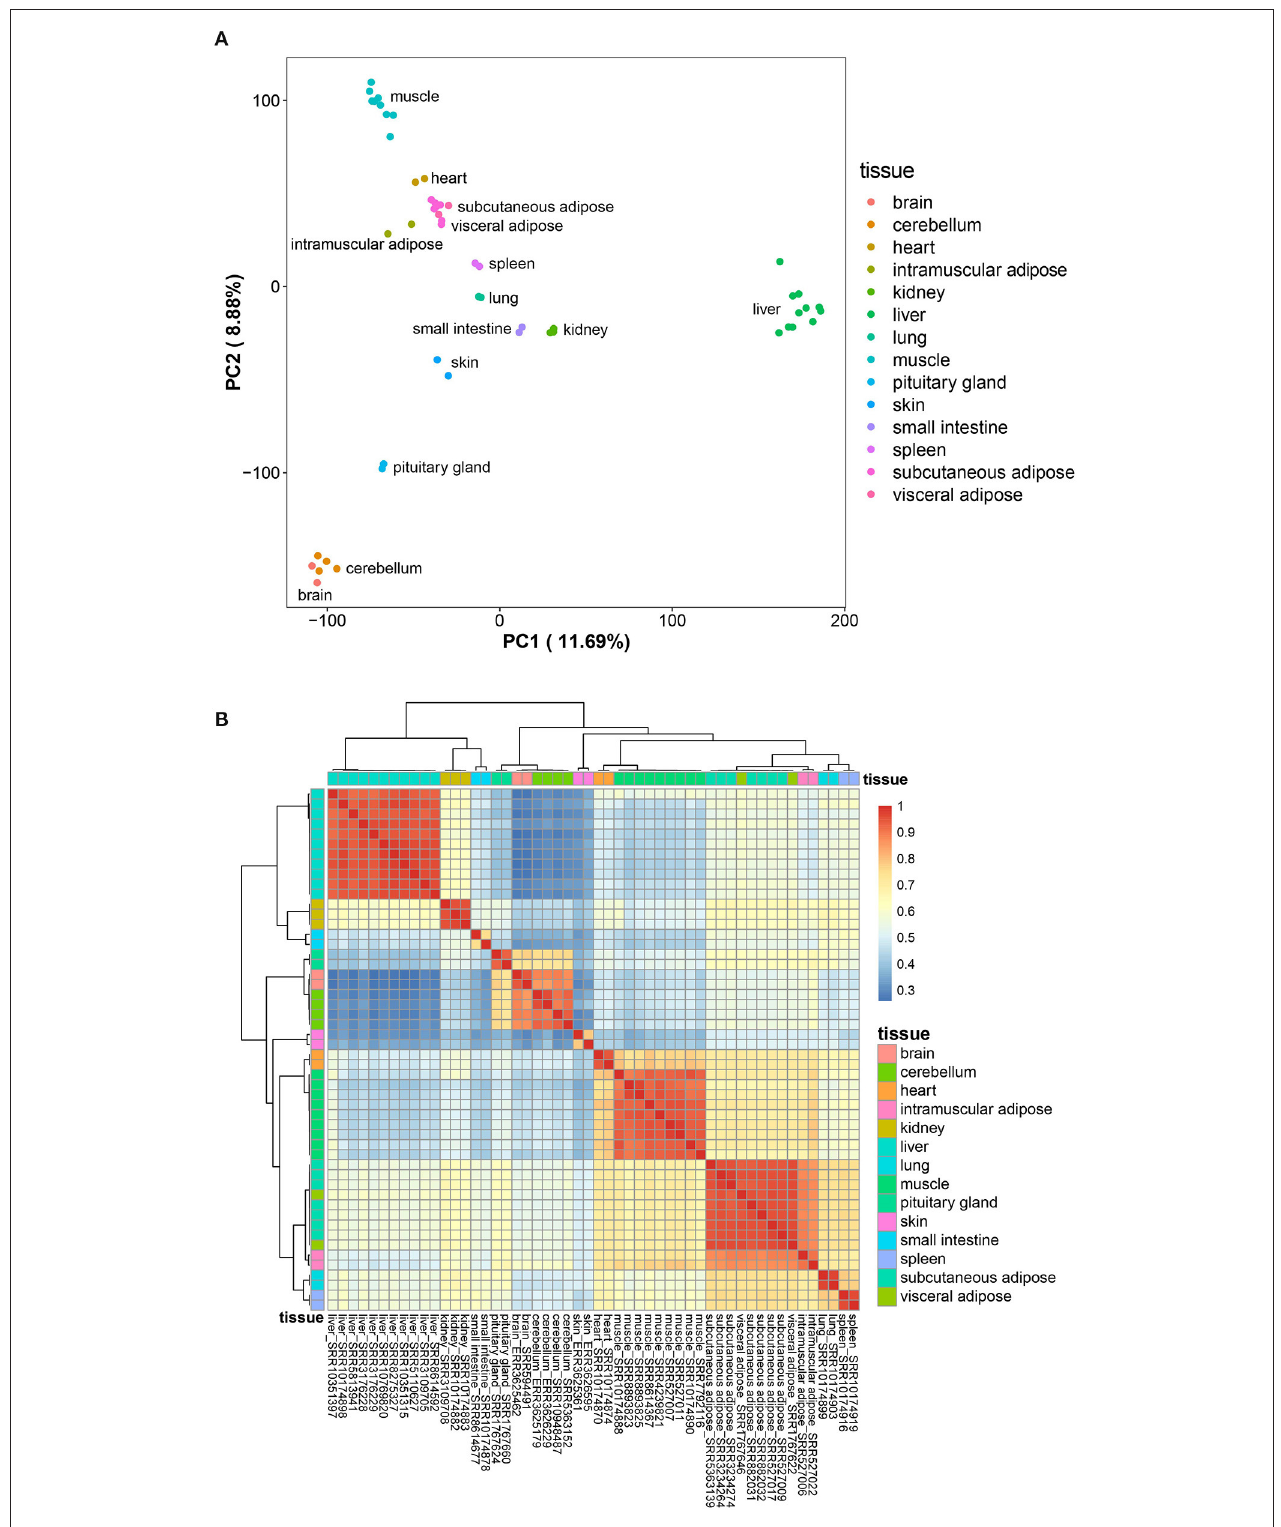
FIGURE 1 | Preliminary analysis of data sets. (A) , Principal component analysis result of the data sets; (B) , the expression profile of the tissue-specific expressed genes.